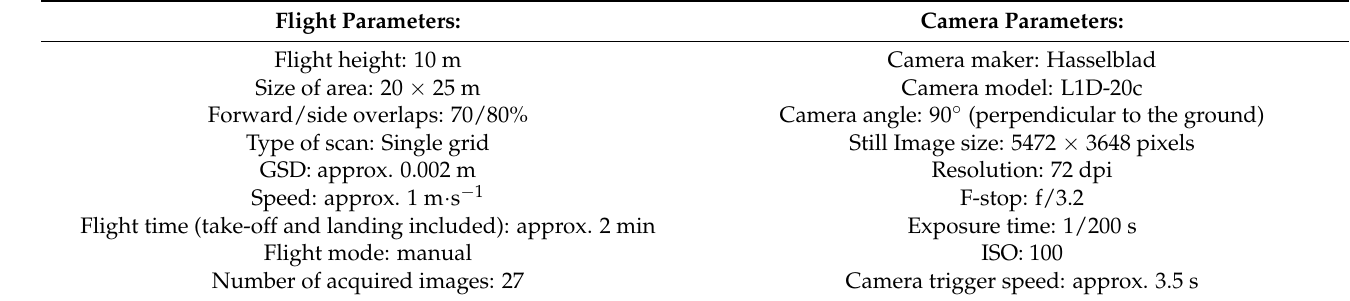
Table 1. Flight and camera parameters (third